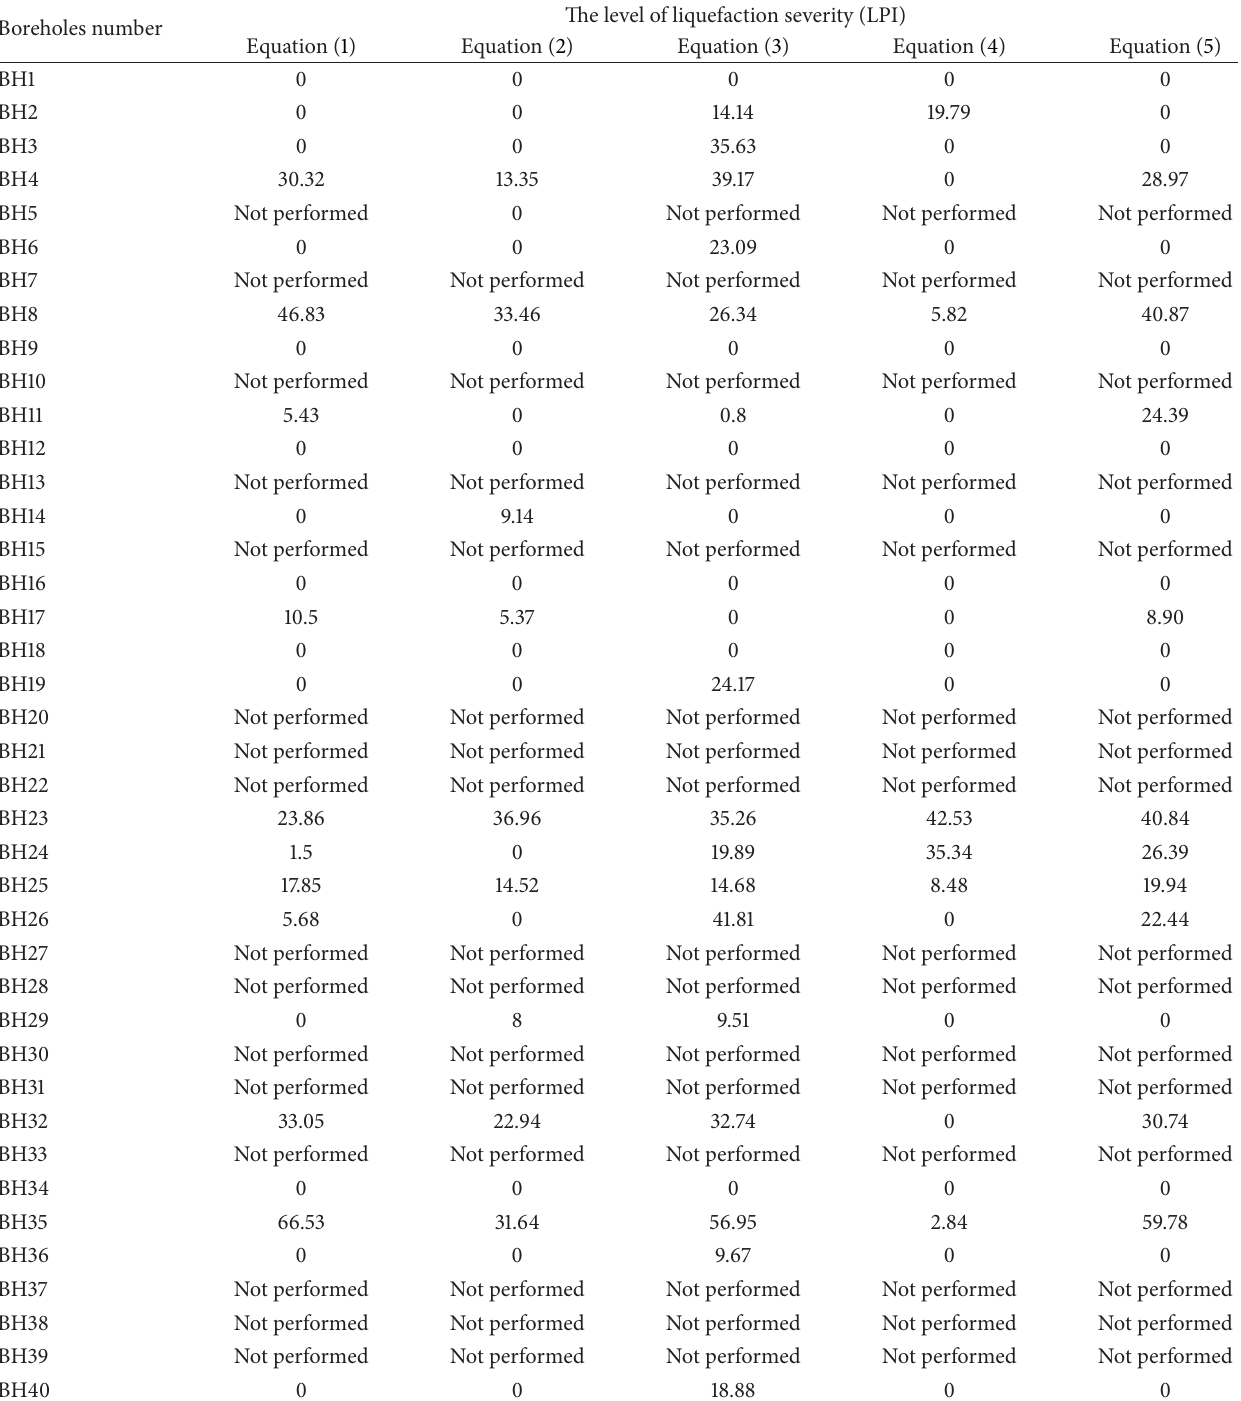
Table 5: Liquefaction potential index